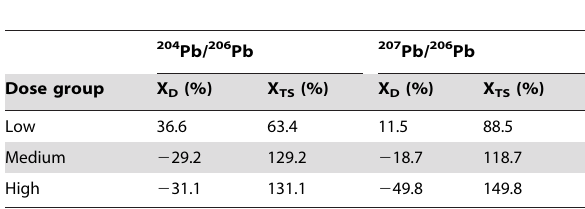
Table 5. The fractional contribution of diet and test substance in different dose group in feces samples.